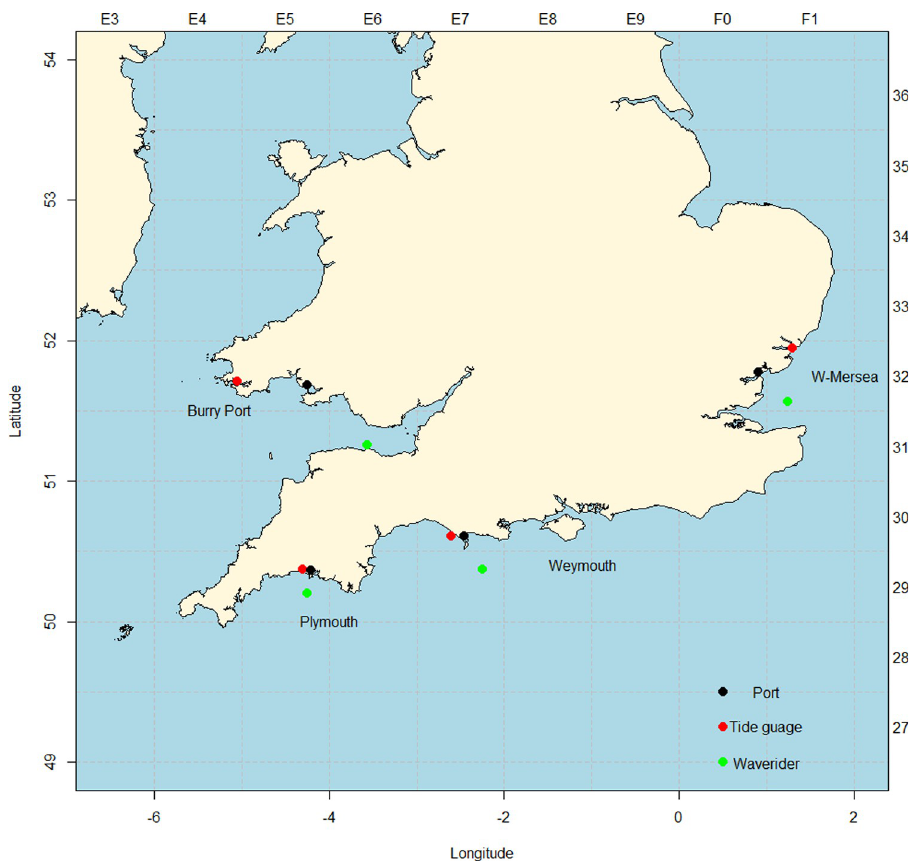
Fig 1. Map of study ports, and instruments from which data was taken. Black dots indicate the study port locations. Red dots and Green dots show the approximate location of tide gauges and wave rider buoys respectively (The map was produced in R version 3.6.1 [32] with the package mapplots [31]).